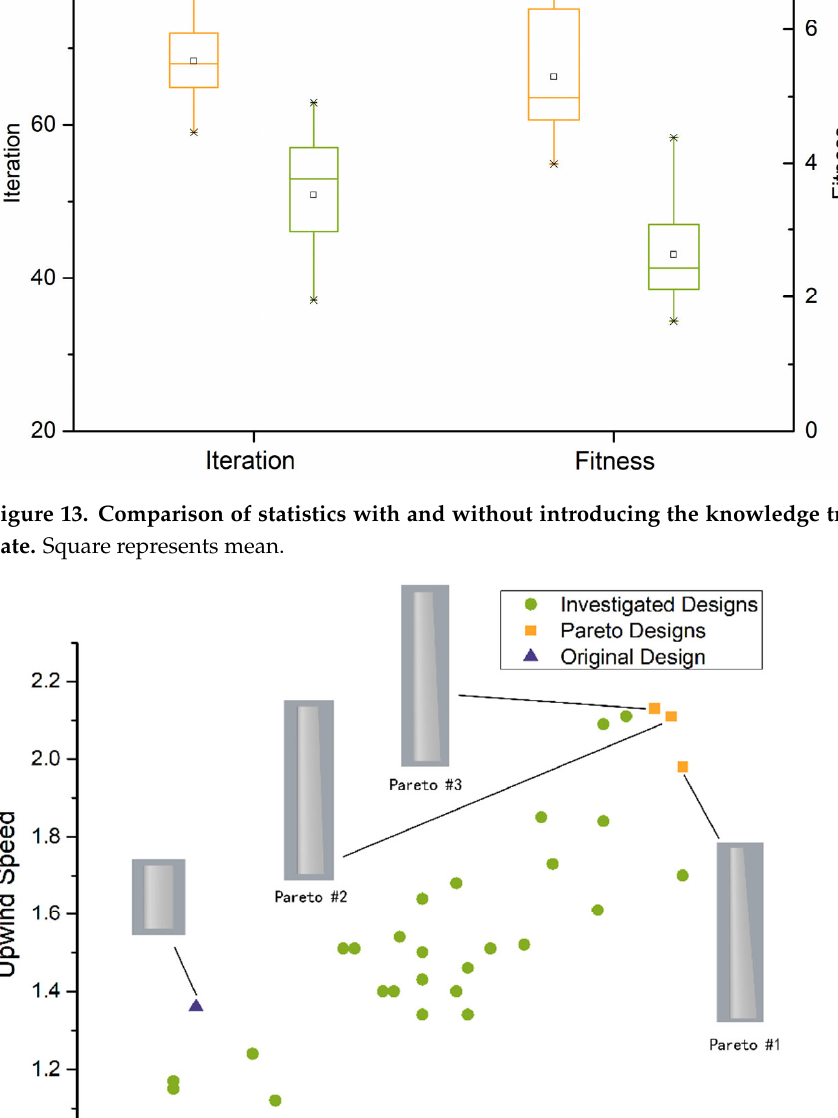
Figure 15. The in fl uence of each of the two design variables on the optimisation objectives. Table 3 compares the performance of the original design and Pareto-optimised de- signs. The results show that the optimisation frame e ff ectively improves the speed perfor- mance of the original design within the design constraints, making more e ffi cient use of the recovery moment of the sailboat while ensuring that the heeling angle does not exceed the permissible value.